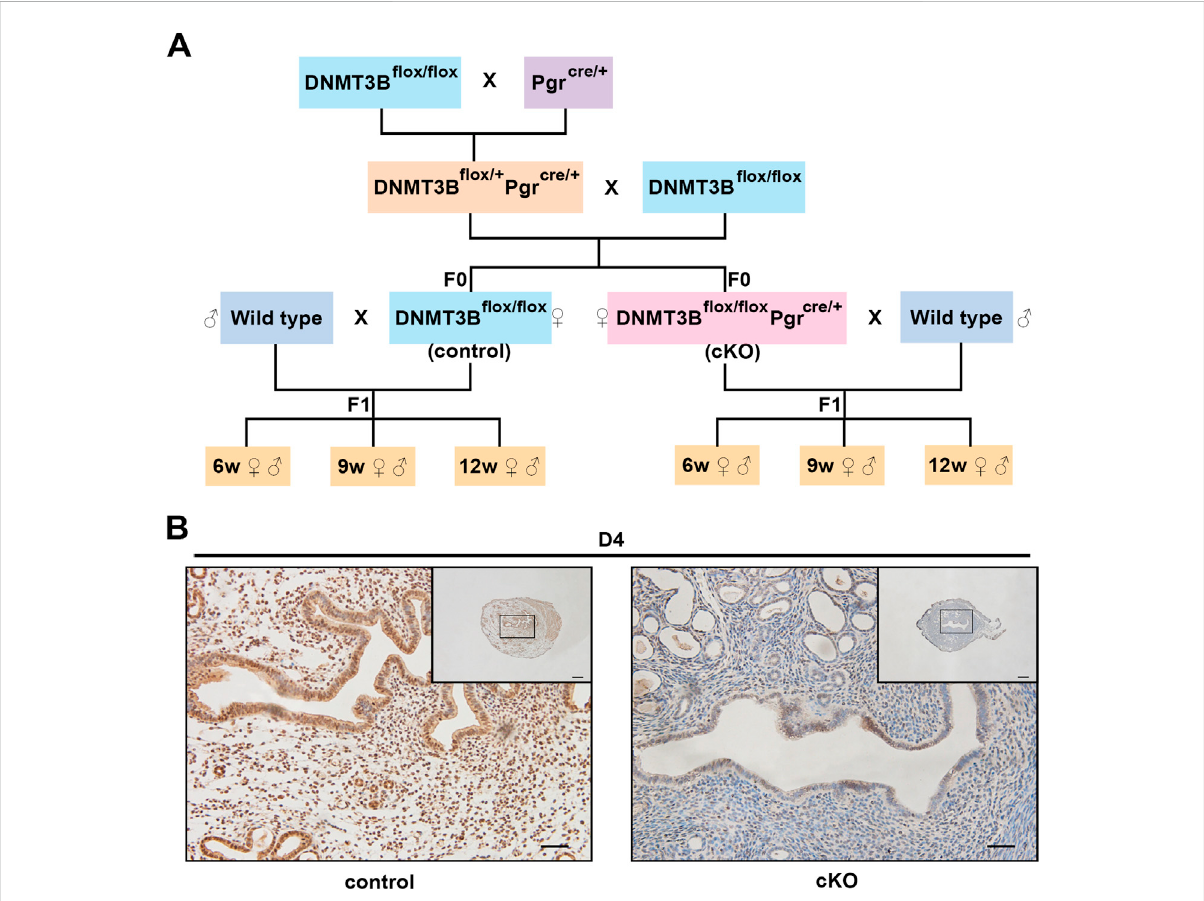
FIGURE 1 The construction and veri fi cation of endometrial DNMT3B conditional knockout female mice (A) DNMT3B fl ox/ fl ox female mice were mated with Pgr Cre/+ male micetoacquire DNMT3B fl ox/+ Pgr Cre/+ male mice. Then, DNMT3B fl ox/+ Pgr Cre/+ male micewerematedwith DNMT3B fl ox/ fl ox femalemiceto acquire DNMT3B fl ox/ fl ox (control) and DNMT3B fl ox/ fl ox Pgr Cre/+ (cKO) female mice. Control or cKO female mice (7 – 10 weeks old) were mated with normal pubescentC57BL/6male mice(wild type).Thus, theF1 generation wasacquiredand divided into three differentlife stages: 6-week-old (juvenile), 9-week-old (sub-adult) and 12-week-old (adult). (B) The expression of uterine endometrial DNMT3B was detected on day 4